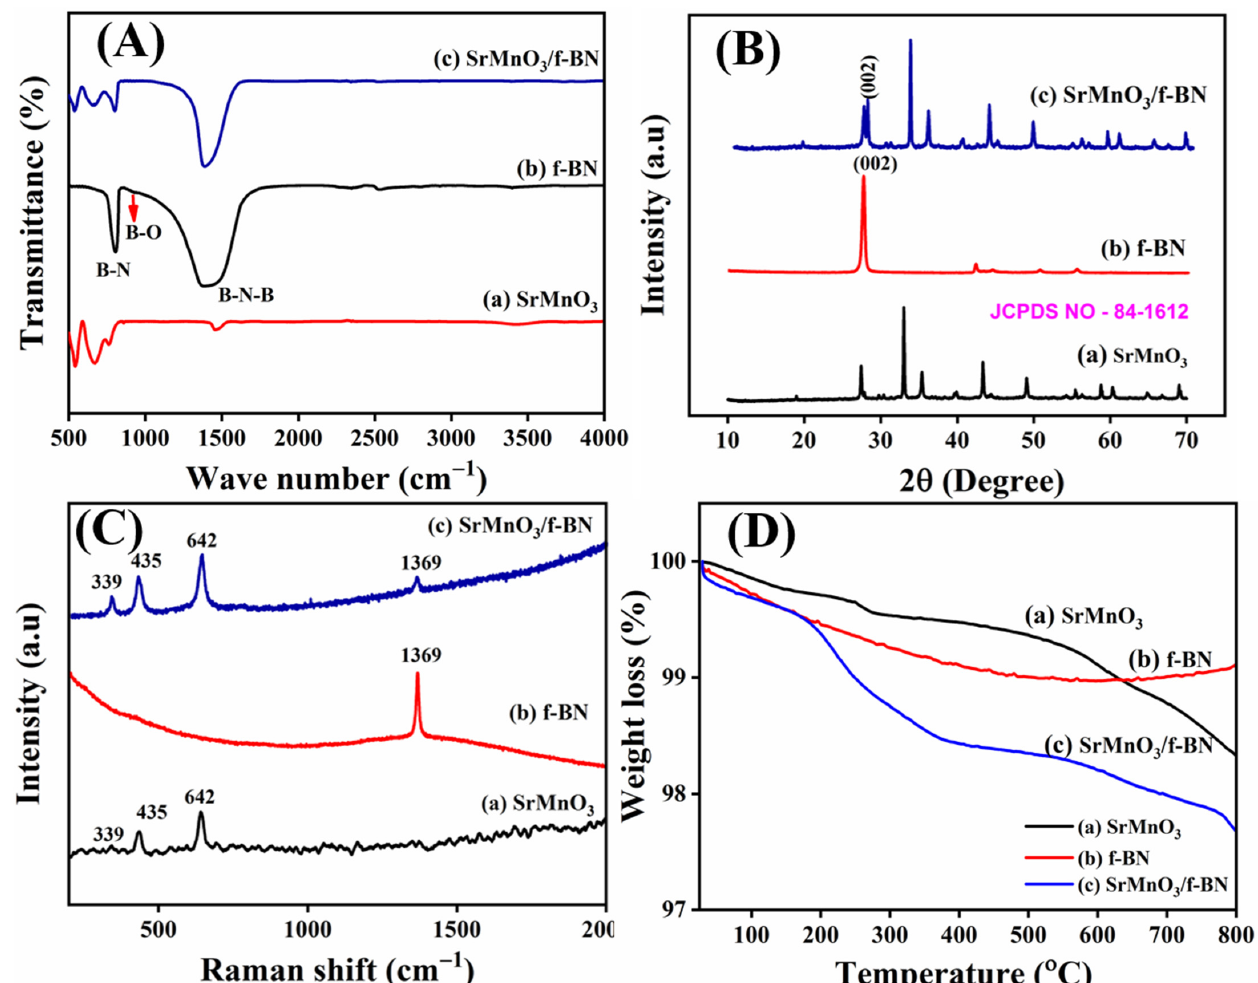
Figure 1. ( A ) FT-IR spectrum, ( B ) XRD pattern, ( C ) Raman spectrum, and ( D ) TGA curves of ( a ) SrMnO 3 , ( b ) f -BN, and ( c ) SrMnO 3 / f -BN composite.